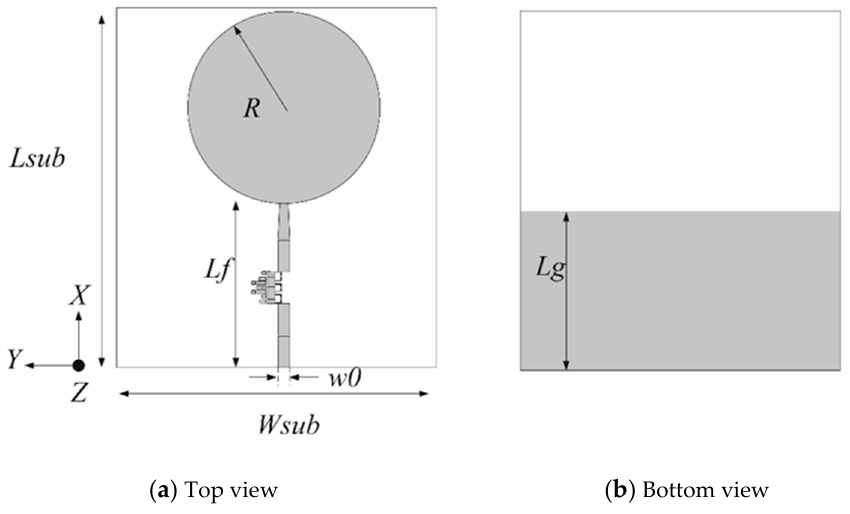
Figure 2. Measured performance of the monocycle pulse of the pulse generator (V2 in Figure 1).